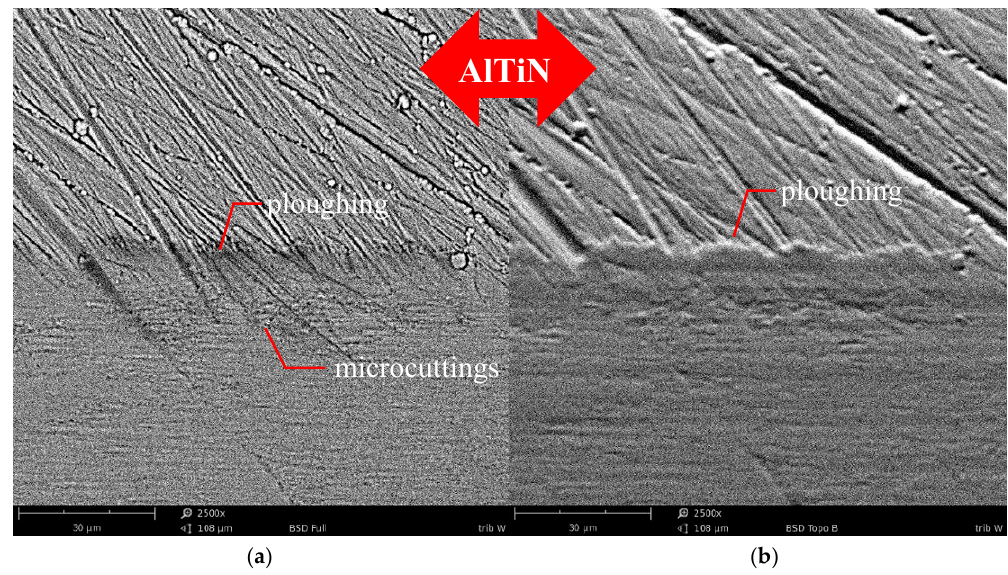
Figure 12. Wear trace on the TiAlN film: ( a ) SEM ‐ BSD and ( b ) SEM ‐ topo, 2500x.